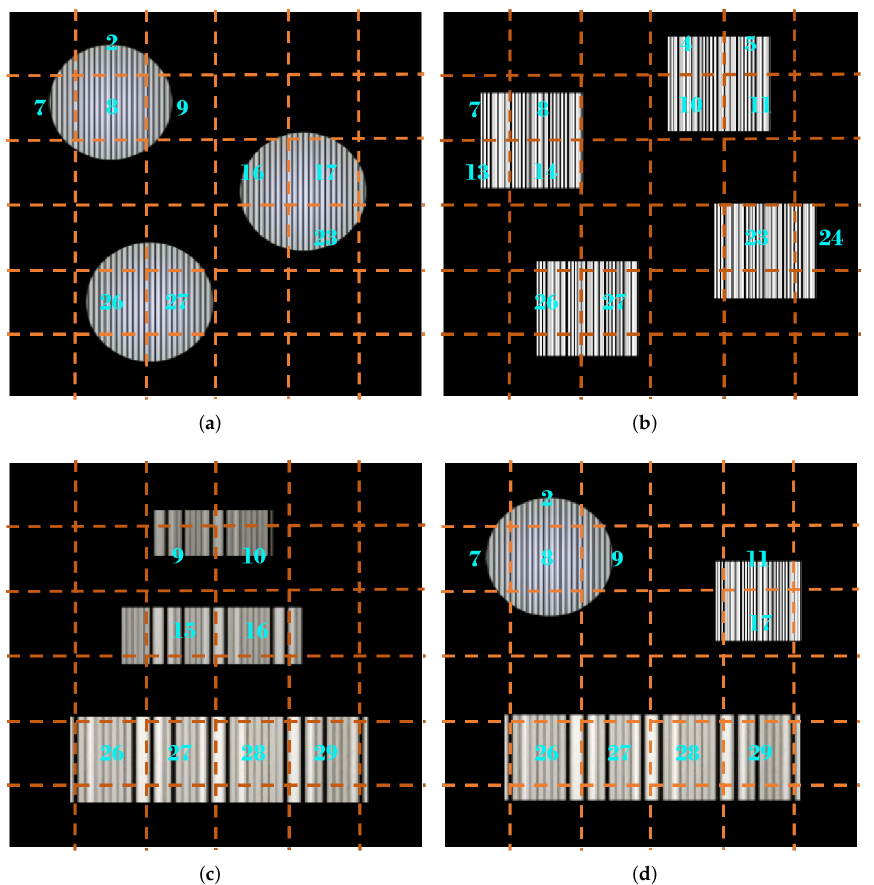
Figure 4. Region of interest projected by transmitters of different shapes in a frame: ( a ) Round LED luminaires. ( b ) Square LED luminaires. ( c ) Rectangular LED luminaires. ( d ) LED luminaires in a variety of